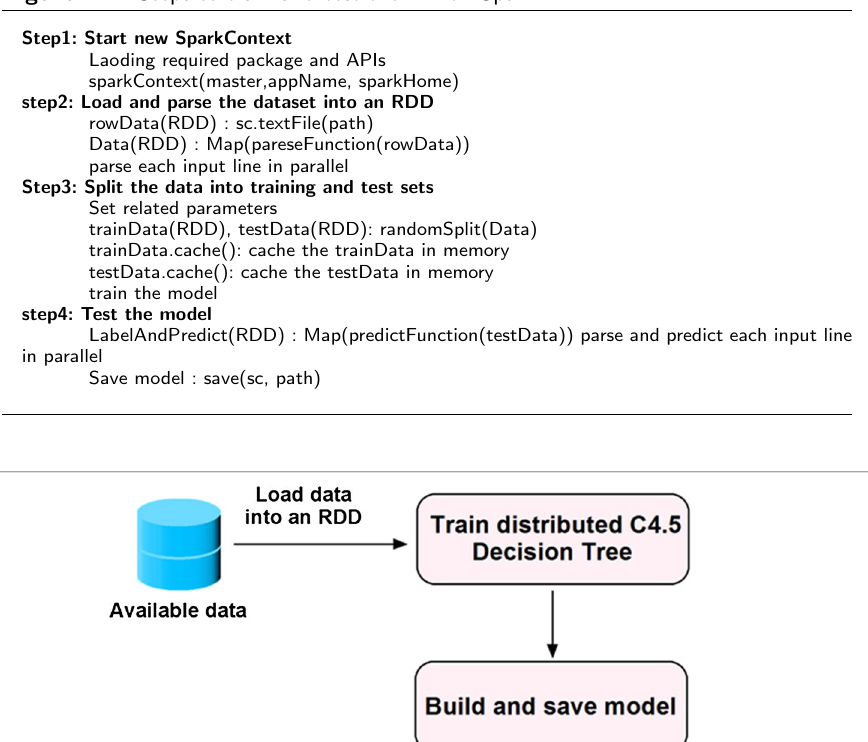
Algorithm 2 Steps to train and test the DT on